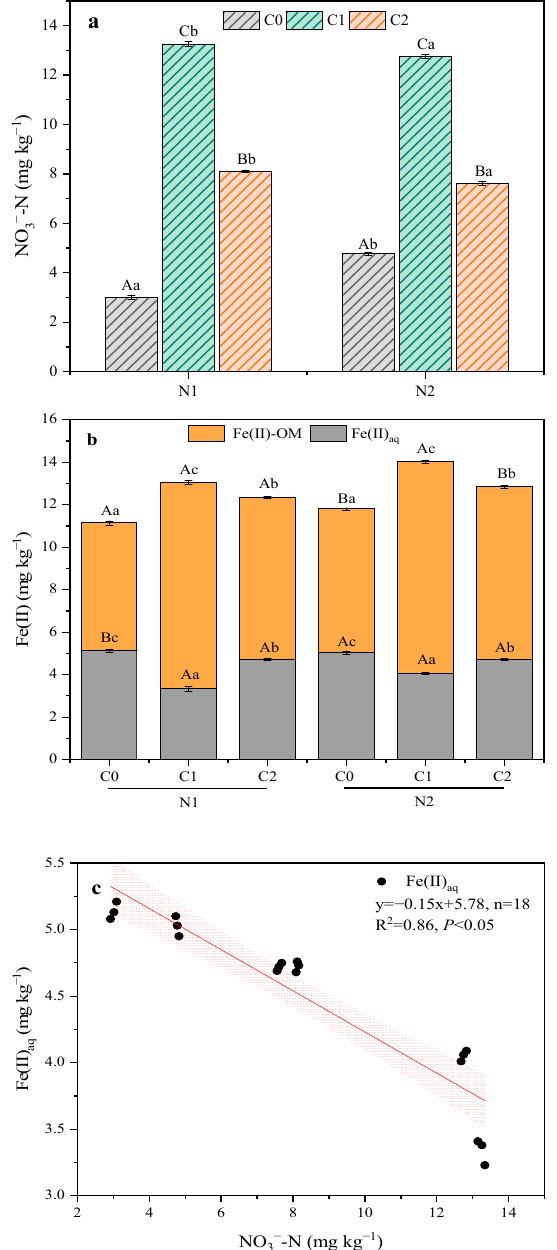
Figure 1. Content of NO 3 − -N ( a ), Fe(II) ( b ) and relationships between NO 3 − -N and Fe(II) aq ( c ) after inputting straw incorporation and N fertilization application rates in saline-alkaline paddy soils. The different lowercase letters indicate significant difference among straw input amounts of the same N application at p < 0.05. Different capital letters indicate a significant difference among N application amounts of the same straw input at p < 0.05.